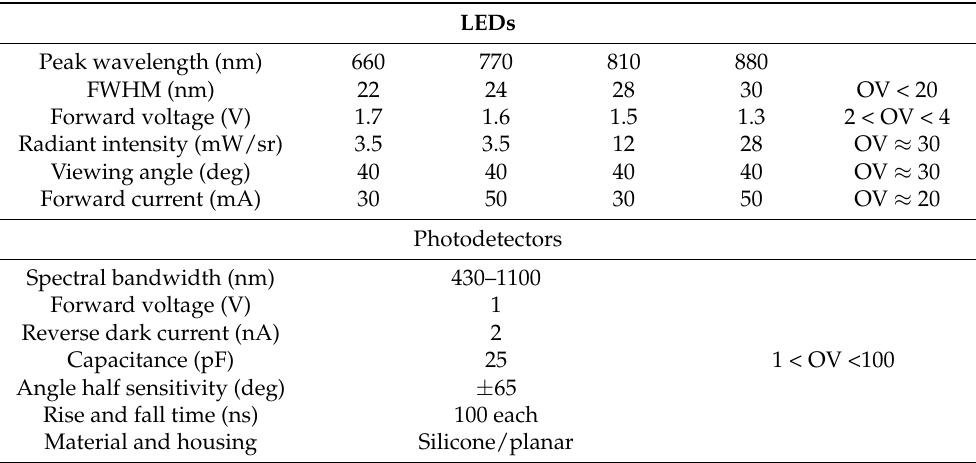
Table 1. Optical characteristics of the light source and